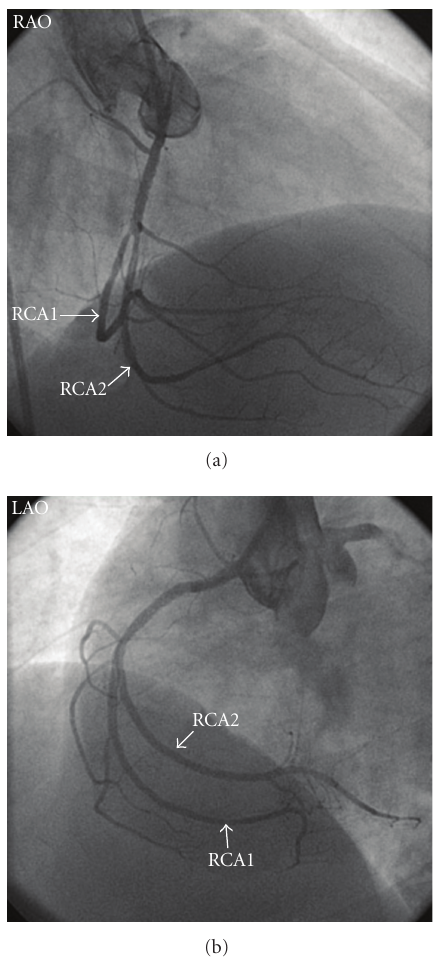
Figure 2: (a) RAO view, after implantation of bare metal stent. (b) LAO view, after implantation of bare metal stent (RAO: Right anterior oblique, LAO: Left anterior